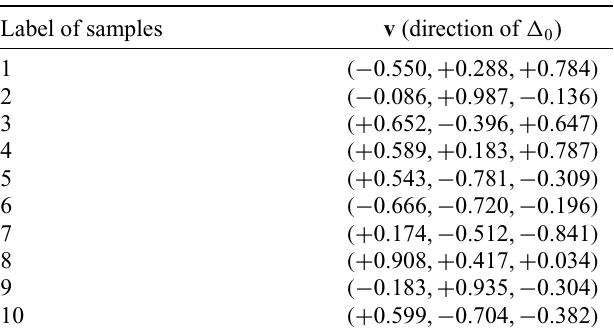
TABLE I. Directions of (cid:11) 0 that are uniformly randomly sam- pled from a sphere. Label of samples